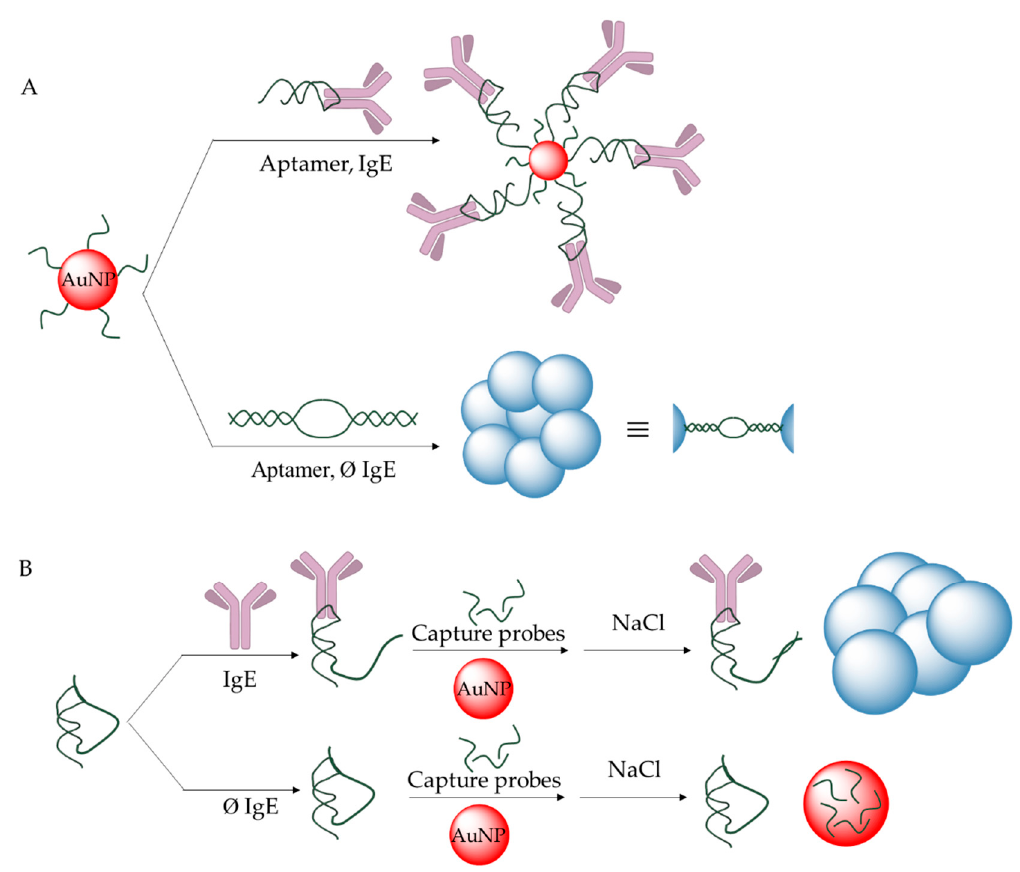
Figure 6. Gold nanoparticle-based colorimetric detection of IgE in solution phase [103,104]. The aggregation of gold nanoparticles could be induced by the absence ( A ) or the presence ( B ) of IgE. A lateral flow sandwich assay was developed for colorimetric determination of IgE using a chemically-modified bacteriophage [106]. In vivo biotinylated peptide (AviTag) was fused to the tail pIII protein of M13 phage to link the biotinylated IgE aptamer through neutravidin. Additionally, the pVIII core protein was covalently modified with HRP to catalyze the oxidation of TMB (3 ′ ,3,5,5 ′ - tetramethylbenzidine) for colorimetric detection. The lateral flow assay contained anti-IgE at the test line, which ensured the selective recognition of IgE, whereas at the control line anti-M13 antibodies were immobilized. With the modified bacteriophage a limit of detection, 0.68 pM was reached.